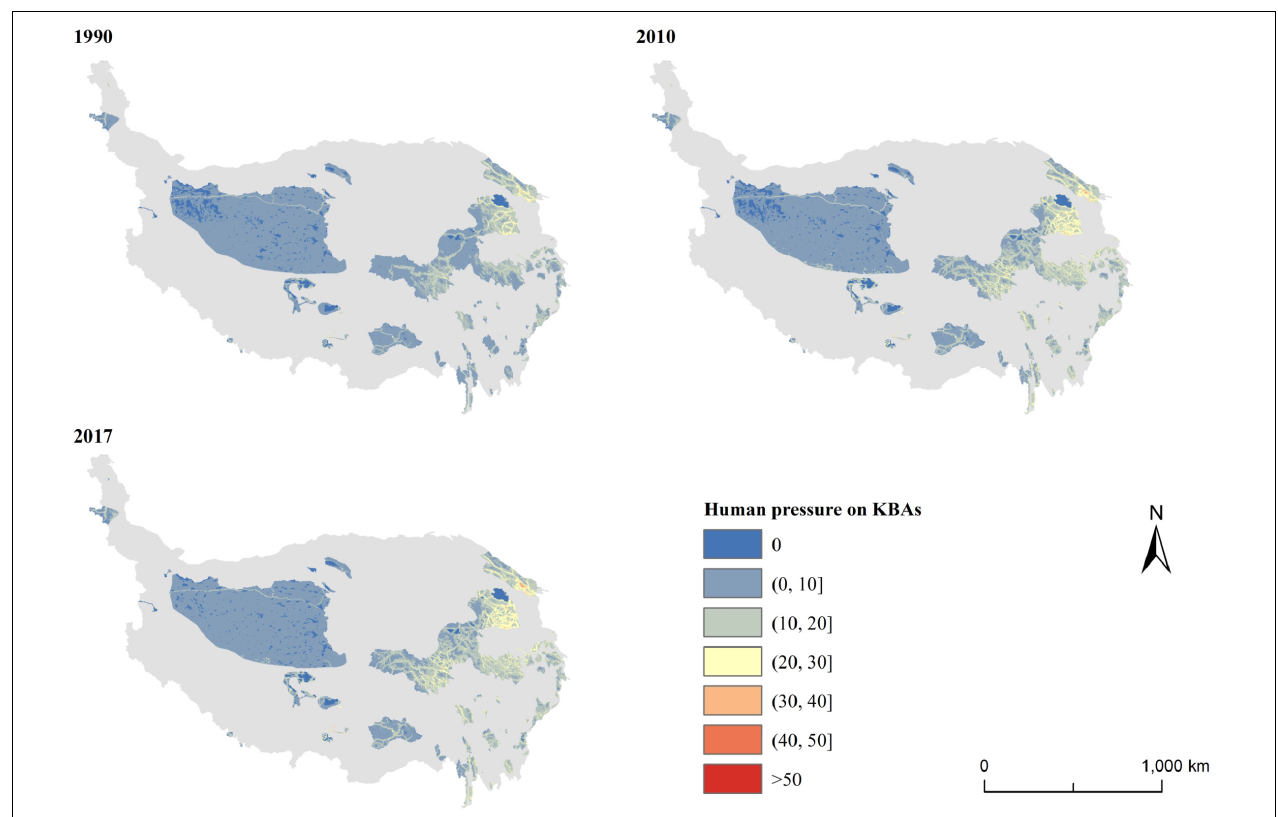
FIGURE 2 | Spatiotemporal pattern of human pressure in KBAs during 1990–2017.